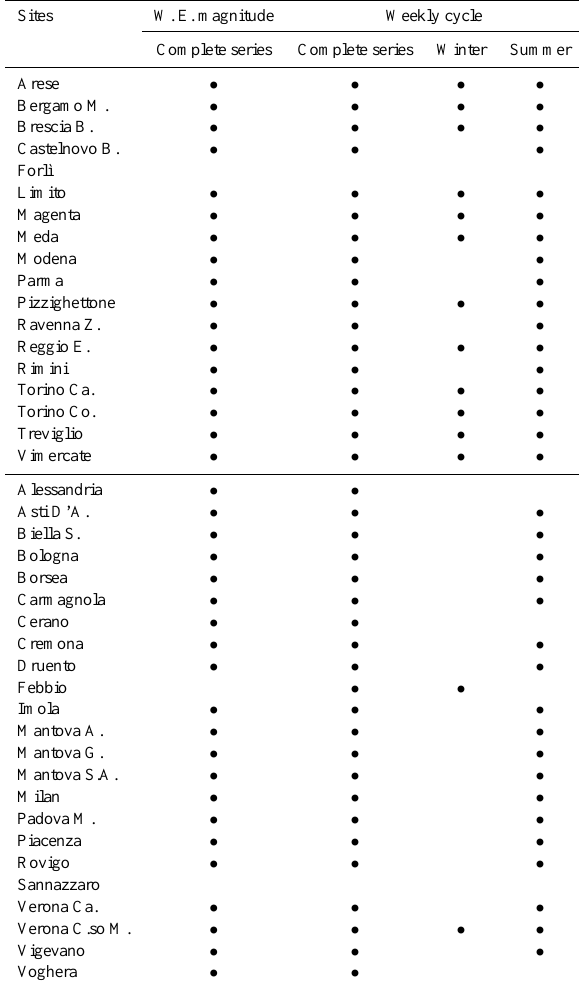
Table 4. Results of weekly cycle analysis on PM 10 : black dots indi- cate a significant weekly cycle or weekend effect (W. E.) magnitude, at a 95% confidence level. Results shown are from test application on full year, winter and summer by grouping data in 7-day